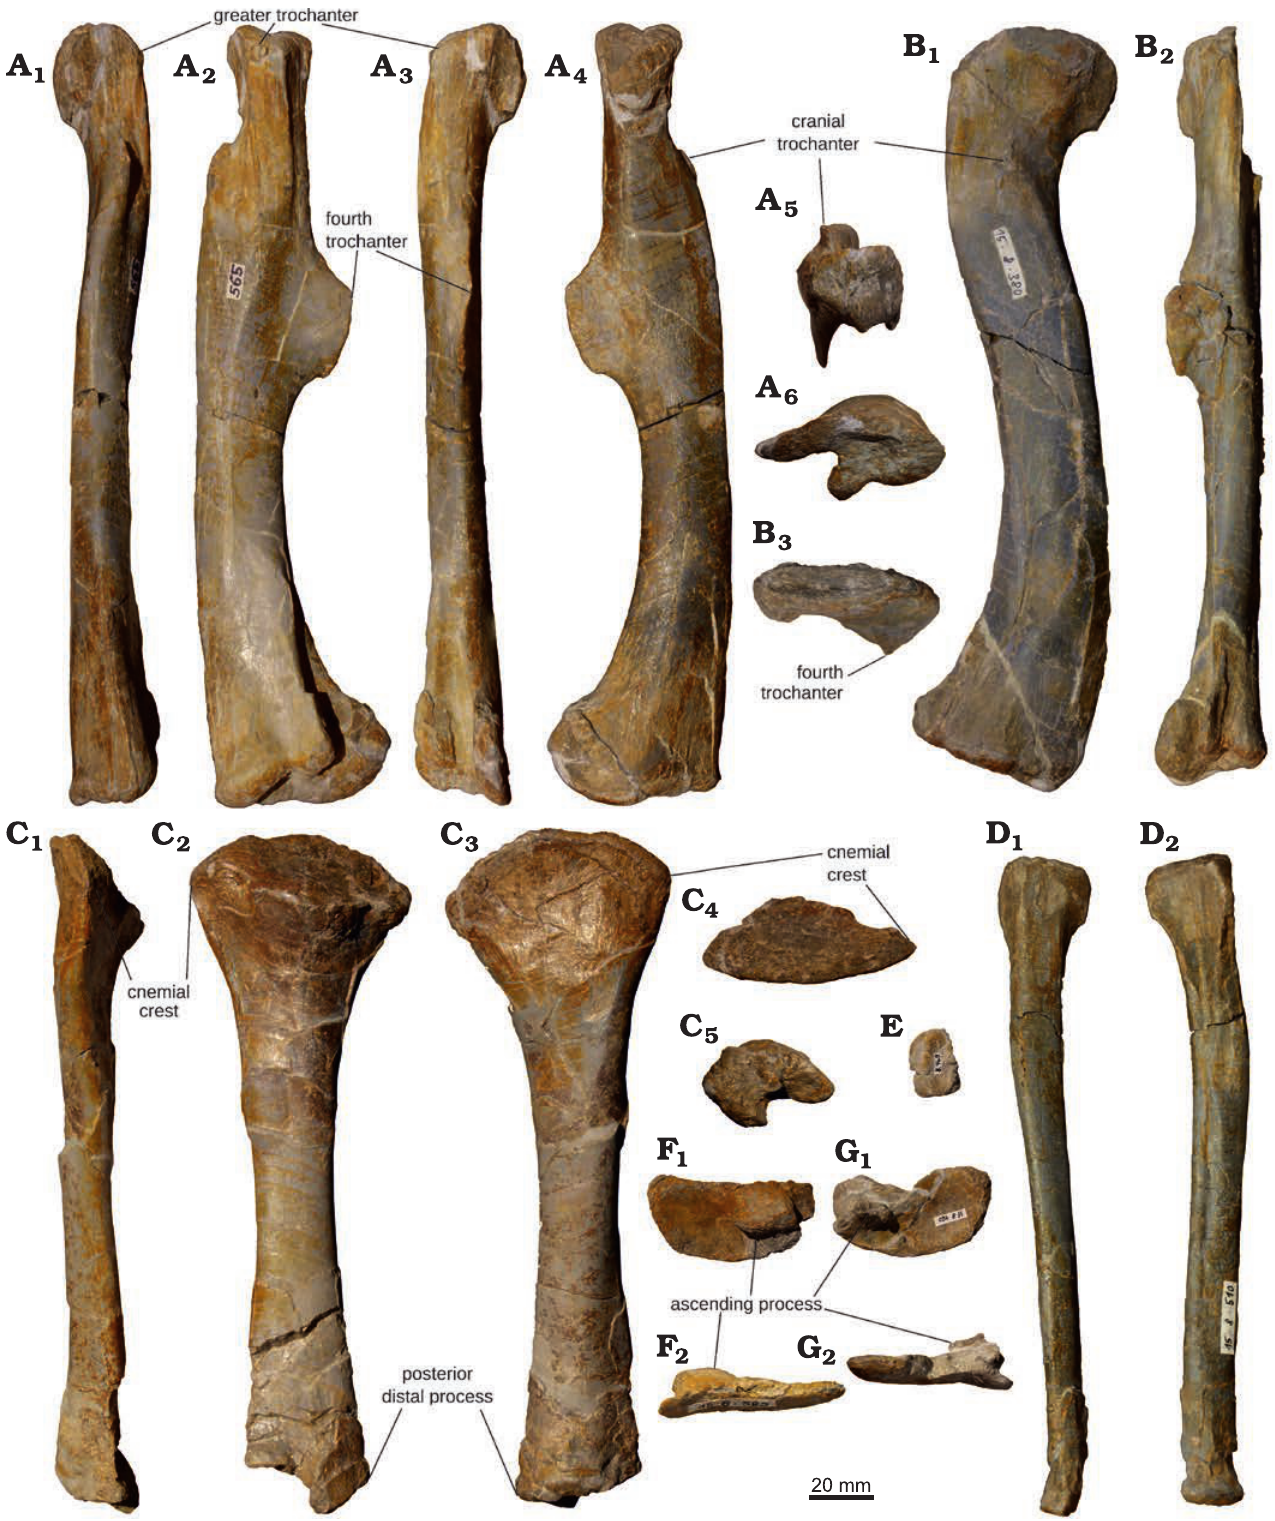
Fig. 11. Femur, tibia, fibula, and proximal tarsus of juvenile Plateosaurus cf. trossingensis Fraas, 1913 skeleton MSF 15.8B. from the Norian of Frick, Switzerland. A . Left femur, MSF 15.8.565, in medial (A 1 ), anterior (A 2 ), lateral (A 3 ), posterior (A 4 ), proximal (A 5 ), and distal (A 6 ) views. B . Right femur, MSF 15.8.380, in lateral (B 1 ), anterior (B 2 ), and proximal (B 3 ) views (note different effects of compaction). C . Left tibia, MSF 15.8.381, in anterior (C 1 ), lateral (C 2 ), medial (C 3 ), proximal (C 4 ), and distal (C 5 ) views. D . Left fibula, MSF 15.8.518, in lateral (D 1 ) and medial (D 2 ) views. E . Right calcaneum, MSF 15.8.469, in proximal view. F . Right astragalus, MSF 15.8.585, in proximal (F 1 ) and anterior (F 2 ) views. G . Left astragalus, MSF 15.8.420, in prox- imal (G 1 ) and anterior (G 2 )